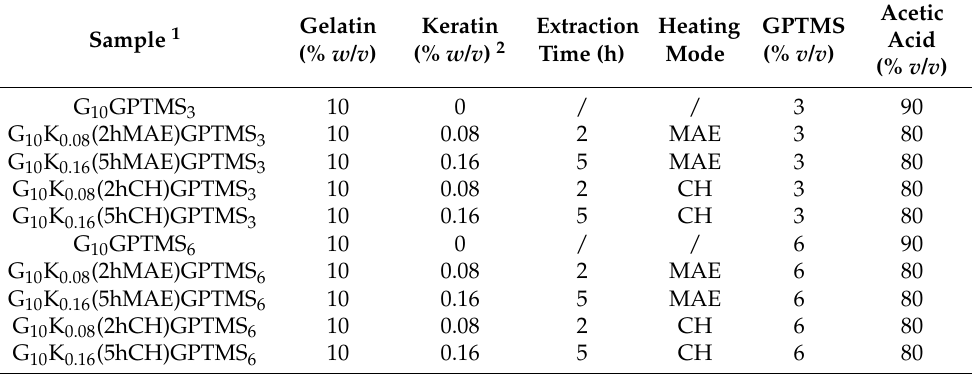
Table 6. Composition of the samples subjected to electrospinning